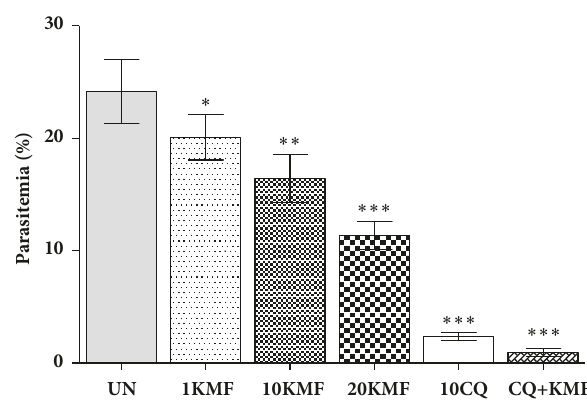
Figure 1: Antimalarial effect of kaempferol on PbANKA in a suppressive test. Groups of ICR mice (3 mice per group) were inoculated with 1x10 7 parasitized erythrocytes of PbANKA by IP injection. Two hours later, they were administered with 1, 10, and 20mg/kg of kaempferol by oral gavage. Untreated control mice received 10ml/kg of DW while positive control mice were given 10mg/kg of CQ. A combination treatment of 10mg/kg of CQ and 20mg/kg of kaempferol was also administered. The treatment was carried out for 4 consecutive days (days 0-3). On day 4, parasitemia was determined by microscopic examination of Giemsa stained thin blood smears. ∗ P < 0.05, ∗∗ P < 0.01, and ∗∗∗ P < 0.001, compared to untreated control. UN; untreated control, 1KMF; 1mg/kg of kaempferol, 10KMF; 10mg/kg of kaempferol, 20KMF; 20 mg/kg of kaempferol, and 10CQ; 10mg/kg of chloroquine. The results are expressed as mean ± SEM.